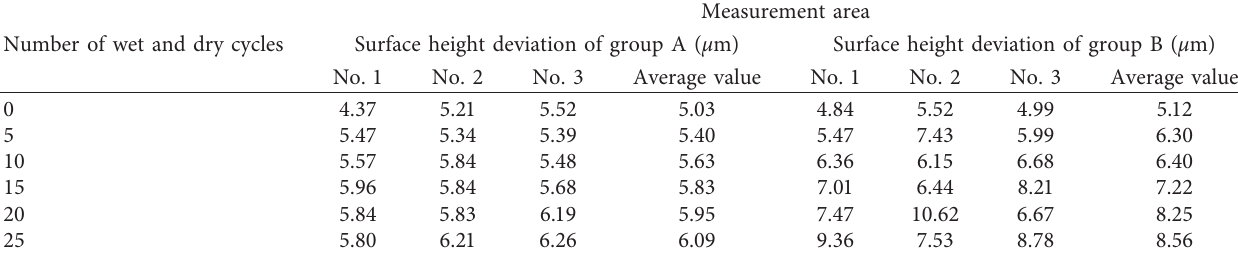
Table 3: Height deviations S a of the feldspar sandstone surface in Groups A and B after the dry-wet cycles. Number of wet and dry